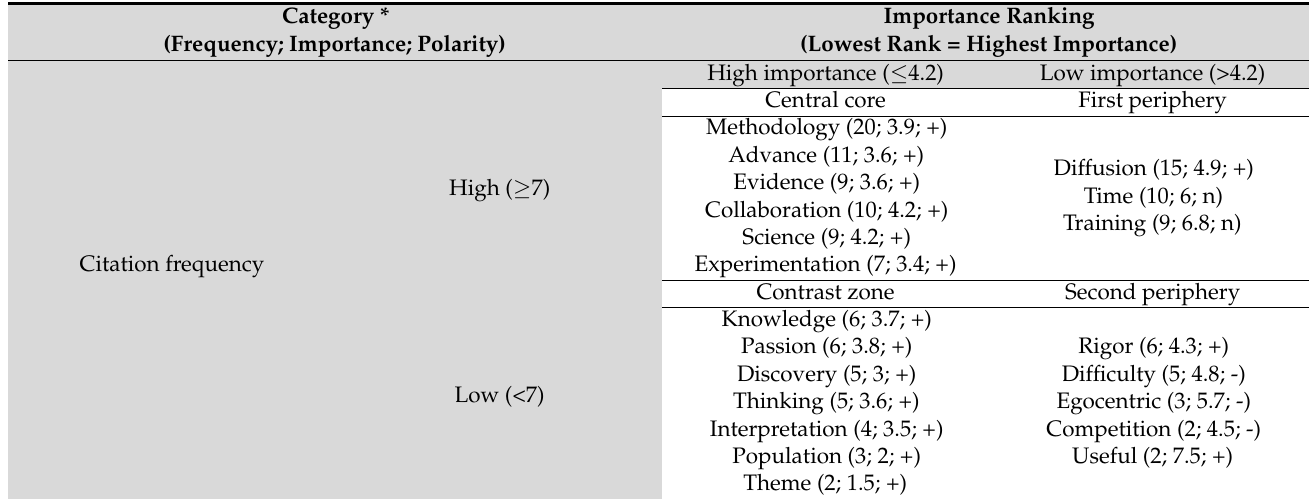
Table 3. Free and ranked association